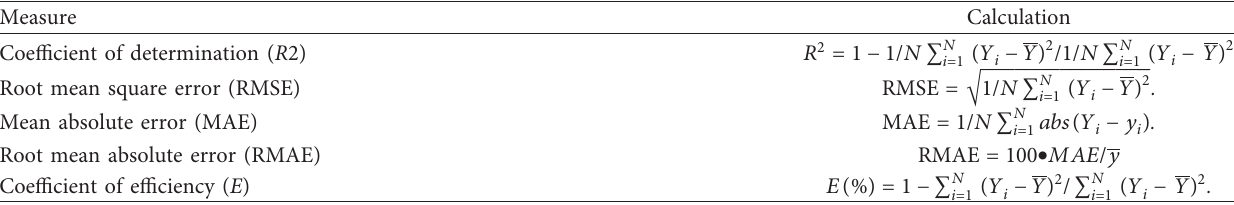
Table 11: Calculation formula of statistical indicators.